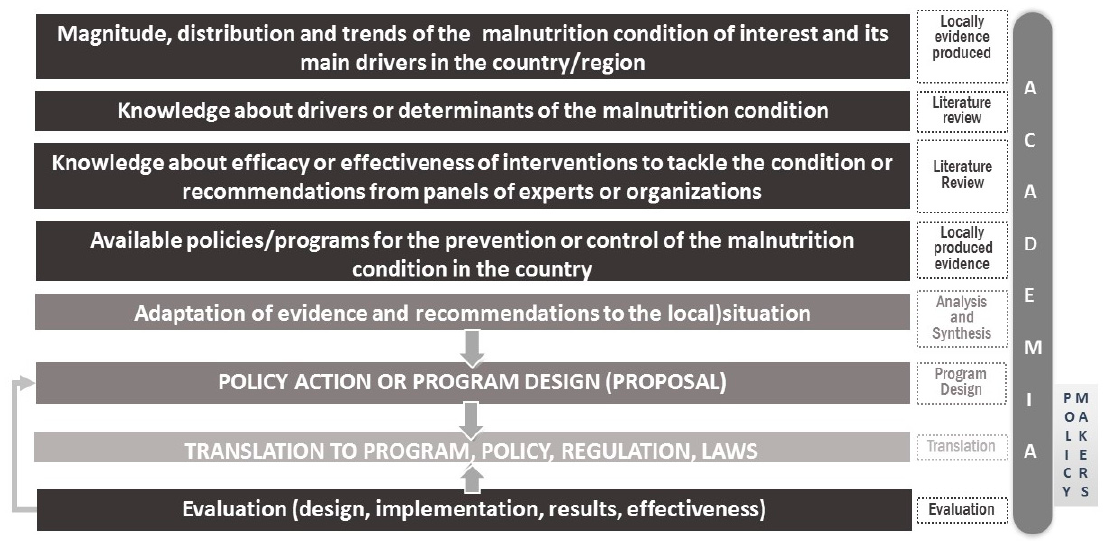
Figure 1. Model for evidence-based design of policies or programs Adapted from a published source [9].